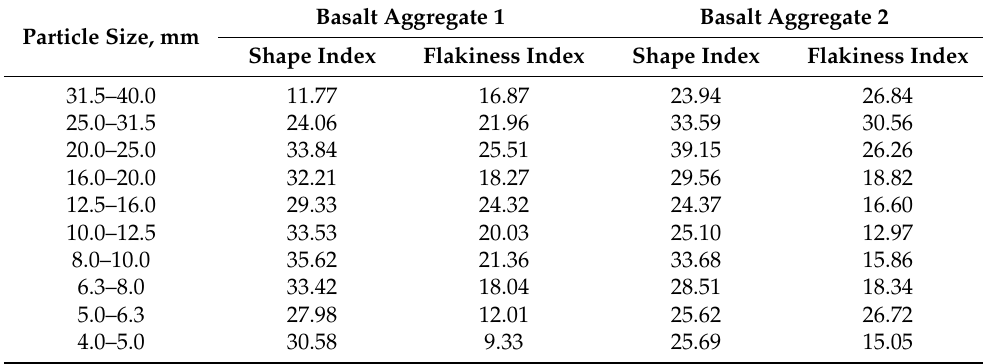
Table 2. Average shape and flakiness indexes for the analyzed igneous aggregates.